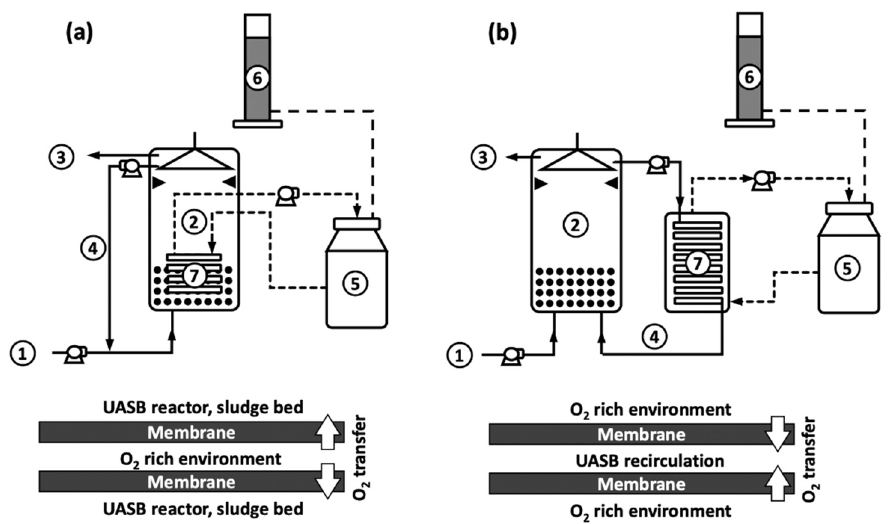
Figure 1. Schematic representation of reactor configurations tested in this study. ( a ) Reactor 1, with submerged silicone membrane; ( b ) Reactor 2, with external mass transfer unit. 1: Upflow anaerobic sludge bed (UASB) feed, 2: UASB reactor, 3: UASB effluent, 4: UASB recirculation, 5: oxygen container, 6: graduated cylinder, 7: silicone membrane. Scheme below each configuration depicts the direction of oxygen transfer (inside/out or outside in).